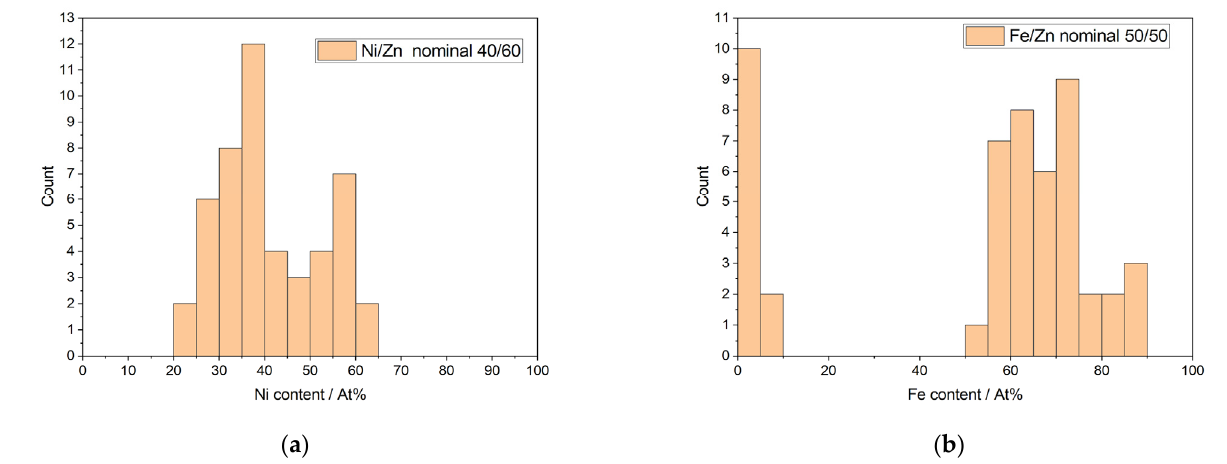
Figure 4. ( a ) Ni content of 48 crystals, and ( b ) Fe content of 49 crystals, as determined by EDX.